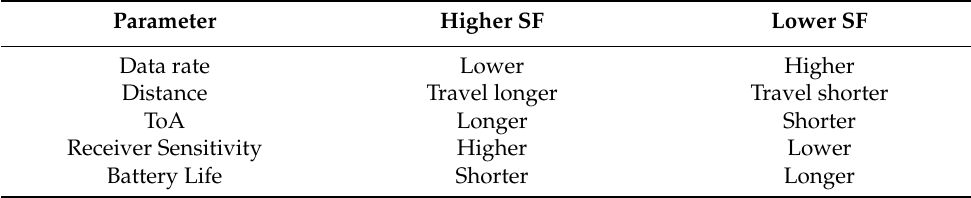
Table 5. Effects of SF on data rate, distance, ToA, receiver sensitivity and battery life. Parameter Higher SF Lower SF Data rate Lower Higher Distance Travel longer Travel shorter ToA Longer Shorter Receiver Sensitivity Higher Lower Battery Life Shorter Longer